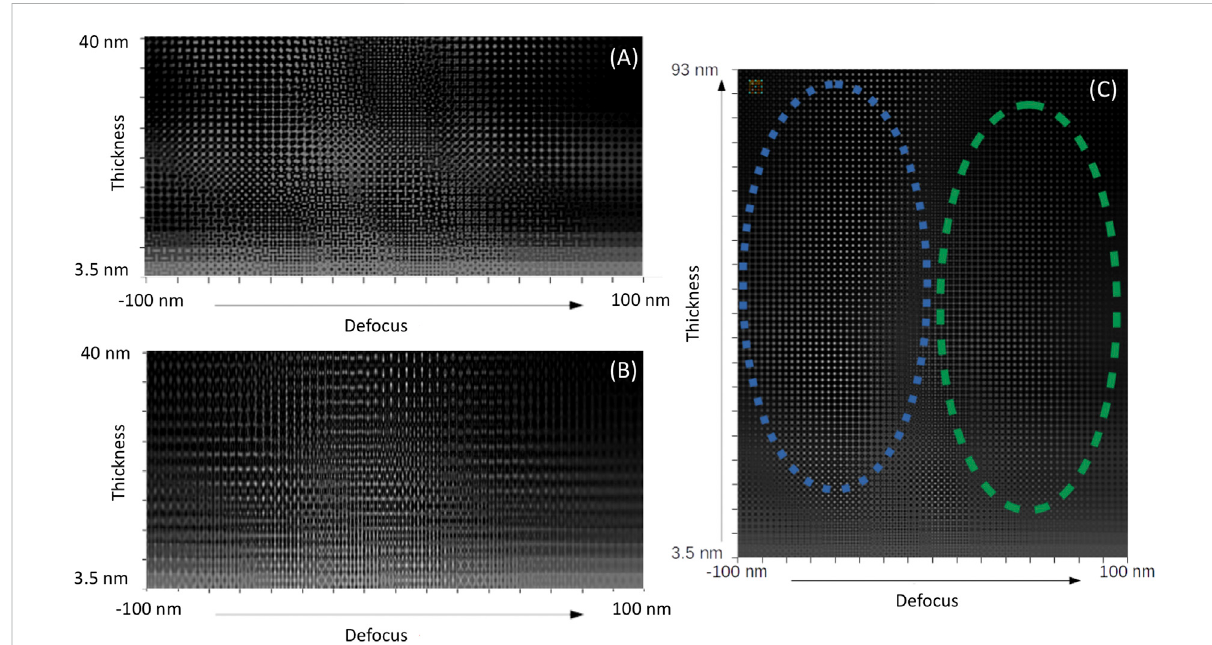
FIGURE 3 Simulated defocus-thickness high-resolution TEM (HRTEM) map. (A) Orthorhombic CsPbBr 3 crystal observed along the [010] direction. (B) Orthorhombic CsPbBr 3 crystal observed along the [101] direction. (C) Cubic CsPbBr 3 crystal observed along the [001] direction. Atomic rows of Cs and Pb are prominent in the blue and green domains, respectively.